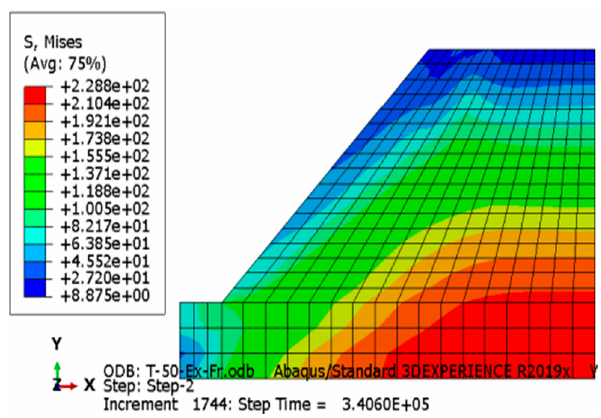
Figure 12. Stress cloud diagram of slope instability after 50 freeze-thaw cycles.